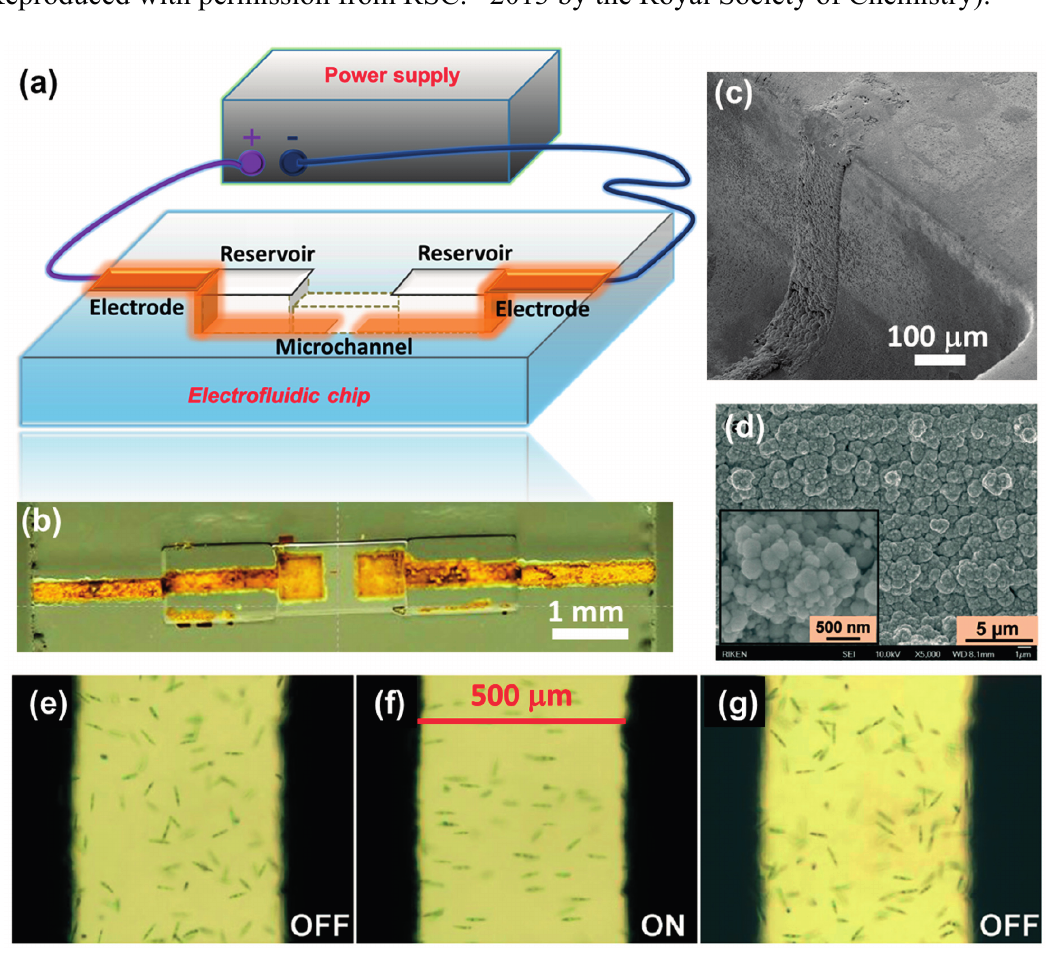
Figure 13. ( a ) Schematic of electrical wiring circuits formed in 3D microfluidic structure connected to an external power supply; ( b ) Photograph of electrofluidic device fabricated in Foturan glass chip using FsLDW (By courtesy of Jian Xu); ( c ) 45° tilted SEM image of metal structure on 350- μ m-high sidewall after electroless copper plating; ( d ) SEM images of microstructure of deposited metal. The inset shows a higher-magnification image. Electro-orientation of Euglena cells in a microfluidic channel ( e ) before applying an electric field; ( f ) when an electric field (~20 Vp-p, 0.9 MHz) was applied and ( g ) when the electric field was turned off. The electrode spacing in all images is 500 μ m [99] (Reproduced with permission from RSC. © 2013 by the Royal Society of